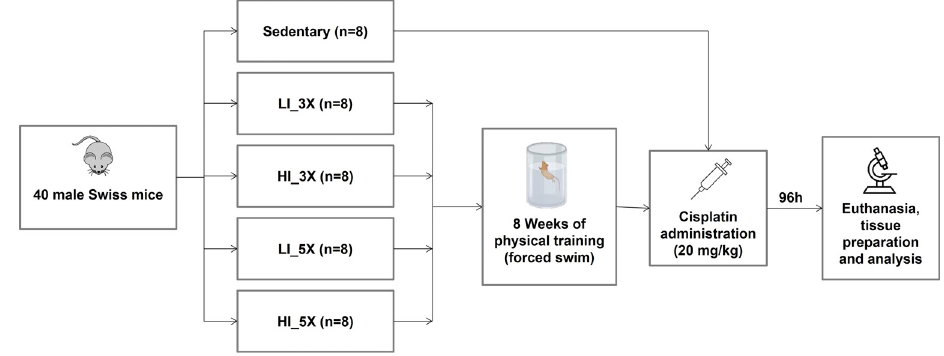
Figure 1. Experimental design. LI: low intensity; HI: high intensity; 3X: three times/week; 5X: fi ve times/week.